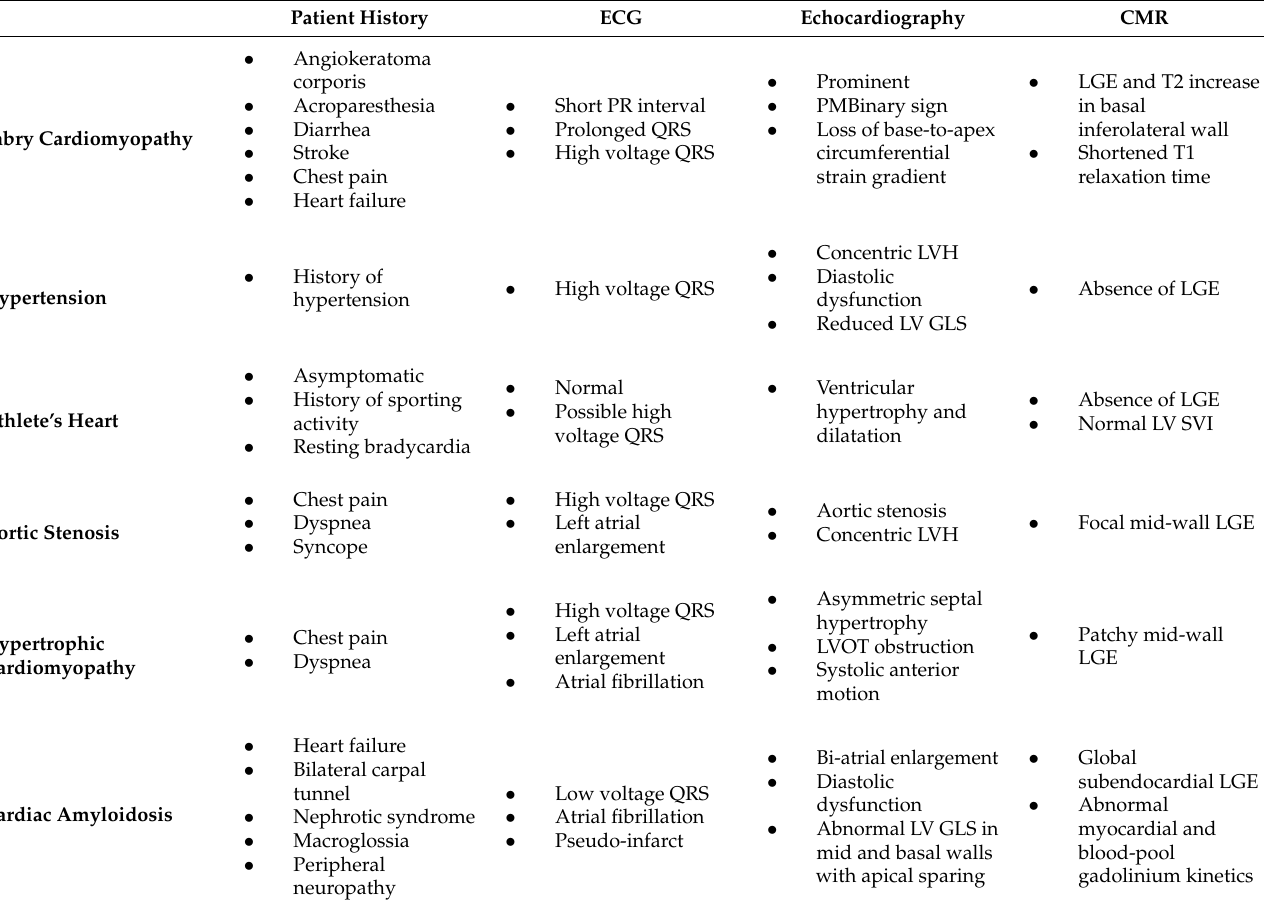
Table 2. Differential diagnosis of increased LV wall thickness and common findings on patient history, ECG, echocardiogra- phy, and